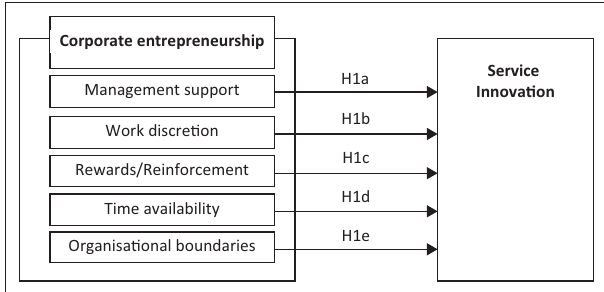
FIGURE 1: Conceptual